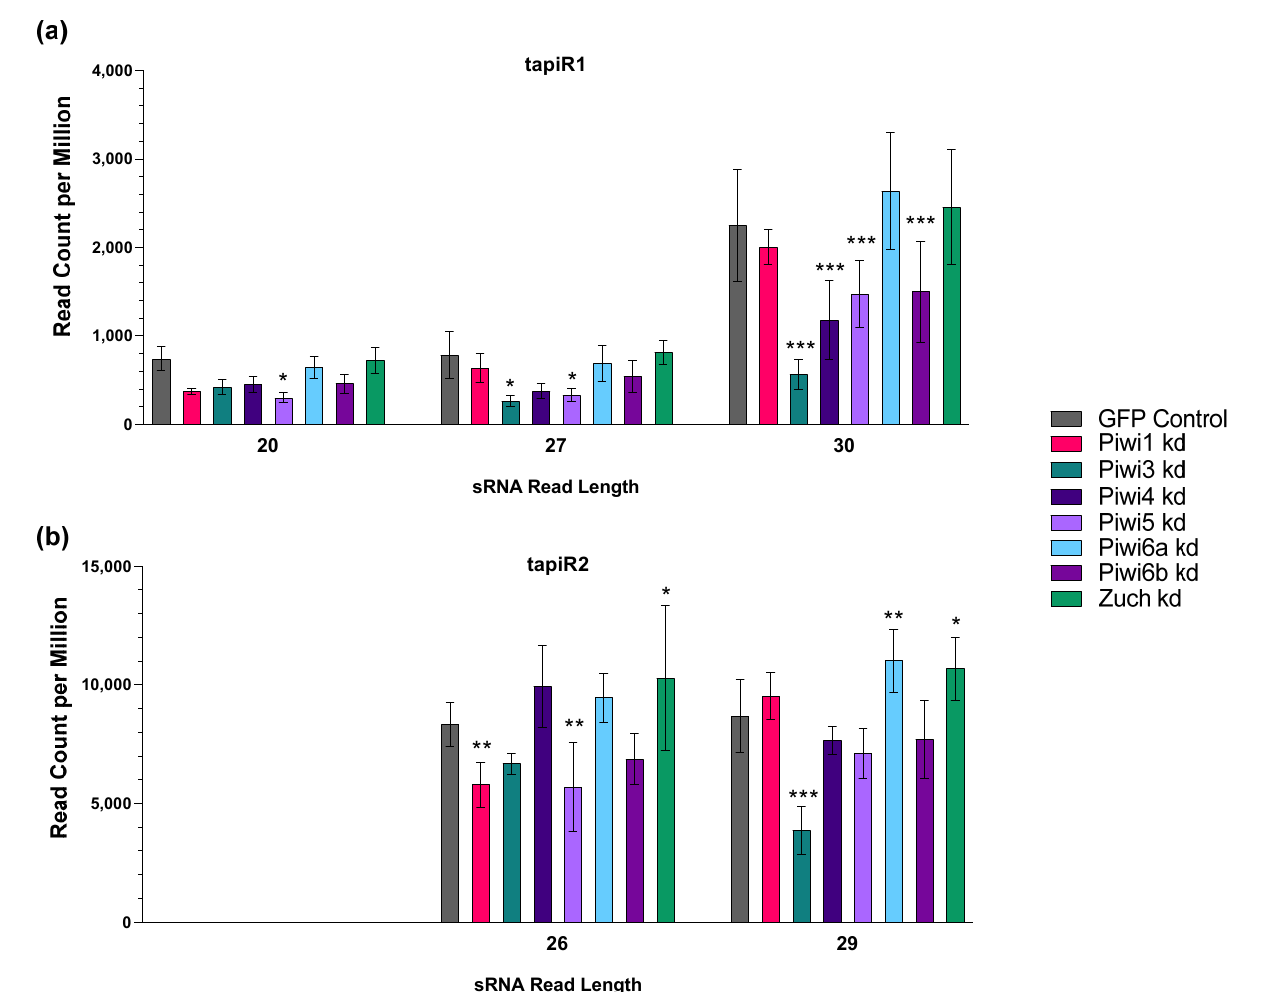
Figure 9. Detection of tapiR1 and tapiR2 in Hsu cells. All sRNA reads from cells treated with PIWI or GFP dsRNA were aligned to tapiR1 ( a ) and tapiR2 ( b ) and the most abundance read lengths were plotted for each piRNA. Significant changes in reads compared to the GFP control are shown as* p < 0.05, ** p < 0.01, and *** p < 0.001.